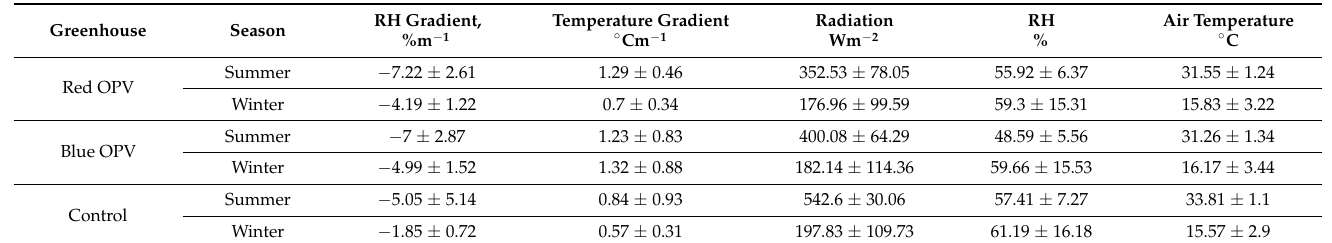
Table 3. Climatic values from greenhouses from summer (22 July to 19 September 2021) and winter (6 December 2021 to 17 January 2022) growing seasons.